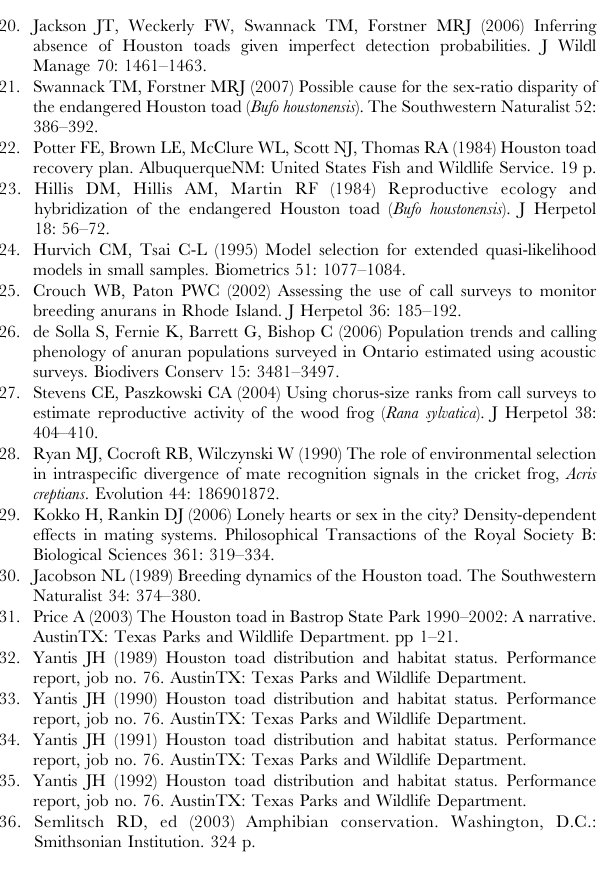
Table S1 Data used in t-test, model fitting, and logistic regression